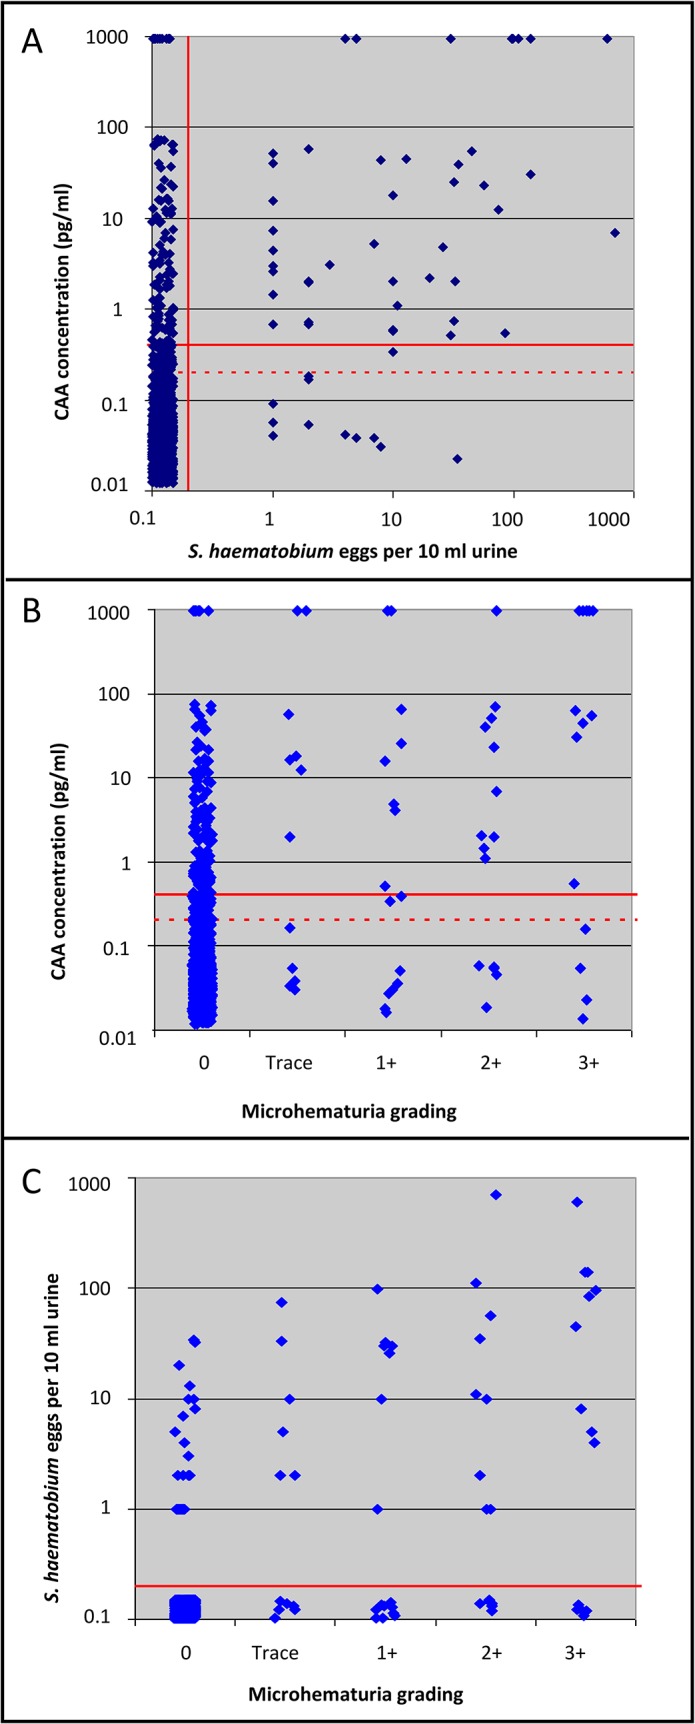
Correlation of circulating anodic antigen (CAA) levels and S. haematobium egg counts or microhematuria grading.(A) Correlation of CAA levels (pg/ml) in 1.5 ml of urine and the number of S. haematobium eggs detected in 10 ml of urine (Spearman’s rho = 0.24; P <0.001); (B) correlation of CAA levels (pg/ml) and the microhematuria grading (Spearman’s rho = 0.23; P <0.001); and (C) correlation of S. haematobium eggs detected and microhematuria grading (Spearman’s rho = 0.57; p<0.001), in urine samples from children from Pemba, United Republic of Tanzania, collected in 2013. The horizontal continuous red line indicates the cut-off value of >0.4 pg/ml for samples clearly indicated as S. haematobium-positive by the UCAA2000 (A and B). The horizontal dotted red line indicates the cut-off value of <0.2 pg/ml for samples clearly indicated as S. haematobium-negative by the UCAA2000 (A and B). Values right from the vertical continuous red line (A) and above the horizontal continuous red line (C) indicate egg-positive urine filtration tests